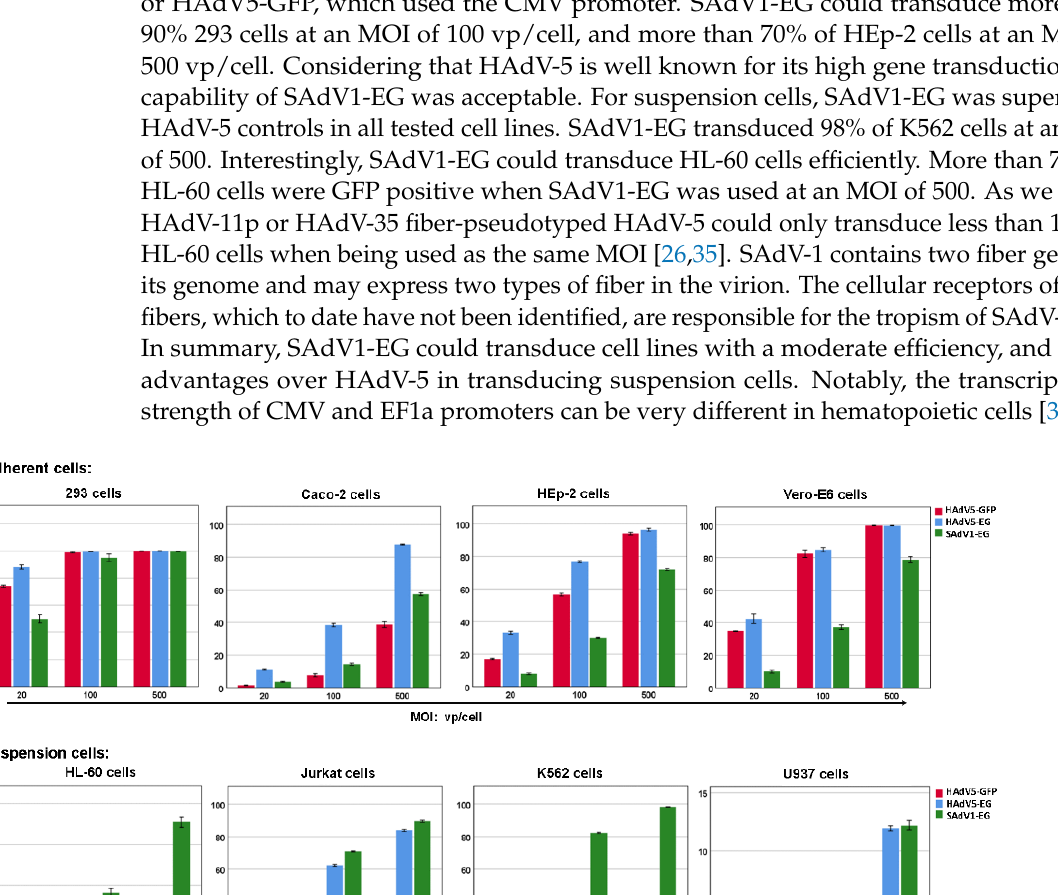
Figure 5. One-step growth curves of SAdV1-EG in 293 or 293SE13 cells. Cells were seeded in 12-well plates and infected with purified SAdV1-EG at an MOI of 1 or 200 vp/cell for 2 h. Cells and the culture media were collected separately at indicated time points post infection. After titration, the yields in each well were calculated and used to construct the growth curves.